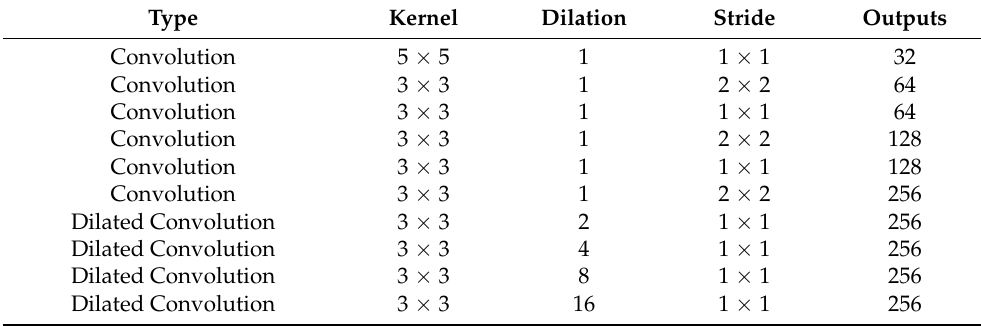
Table 1. Detailed architecture of shared encoding network.